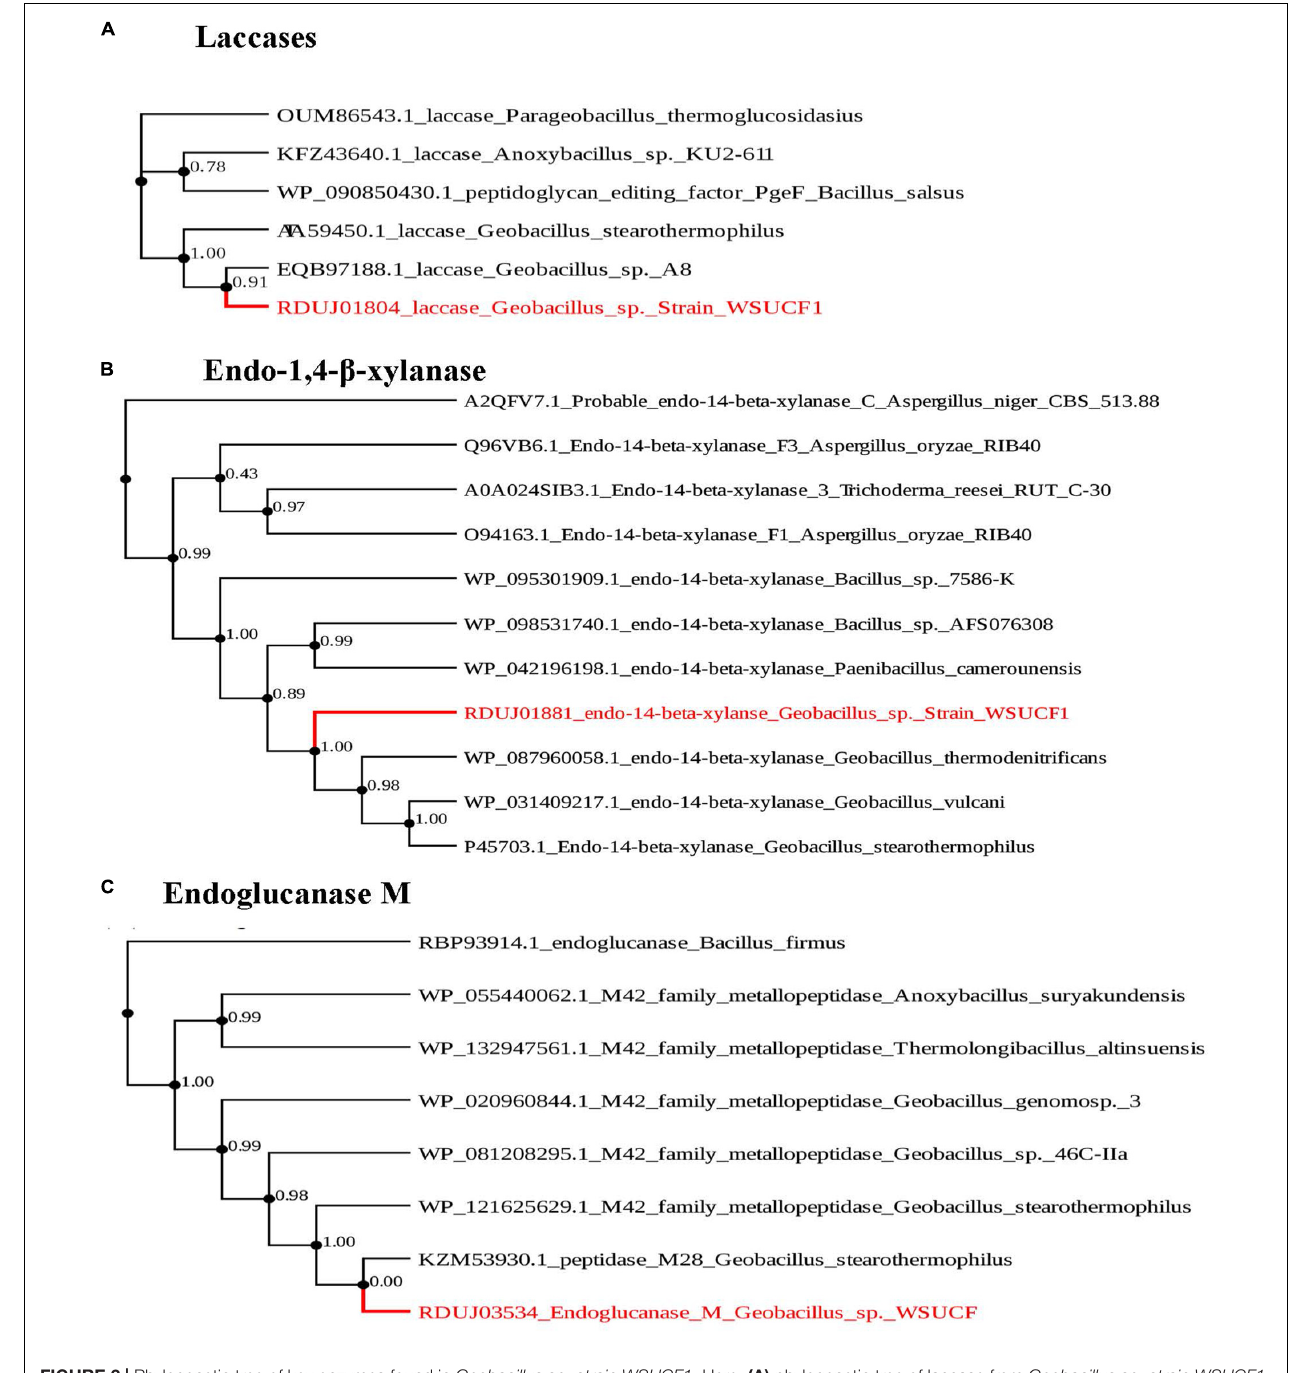
Frontiers in Microbiology |